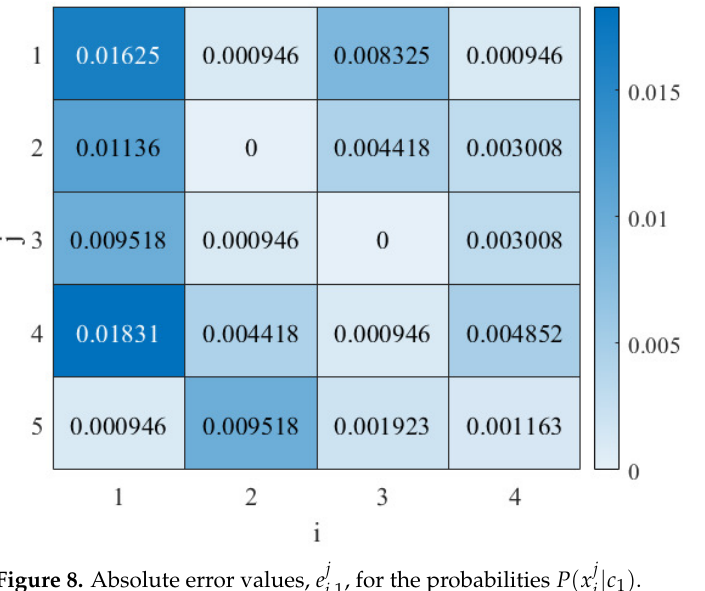
, for the probabilities P ( x j i ,1